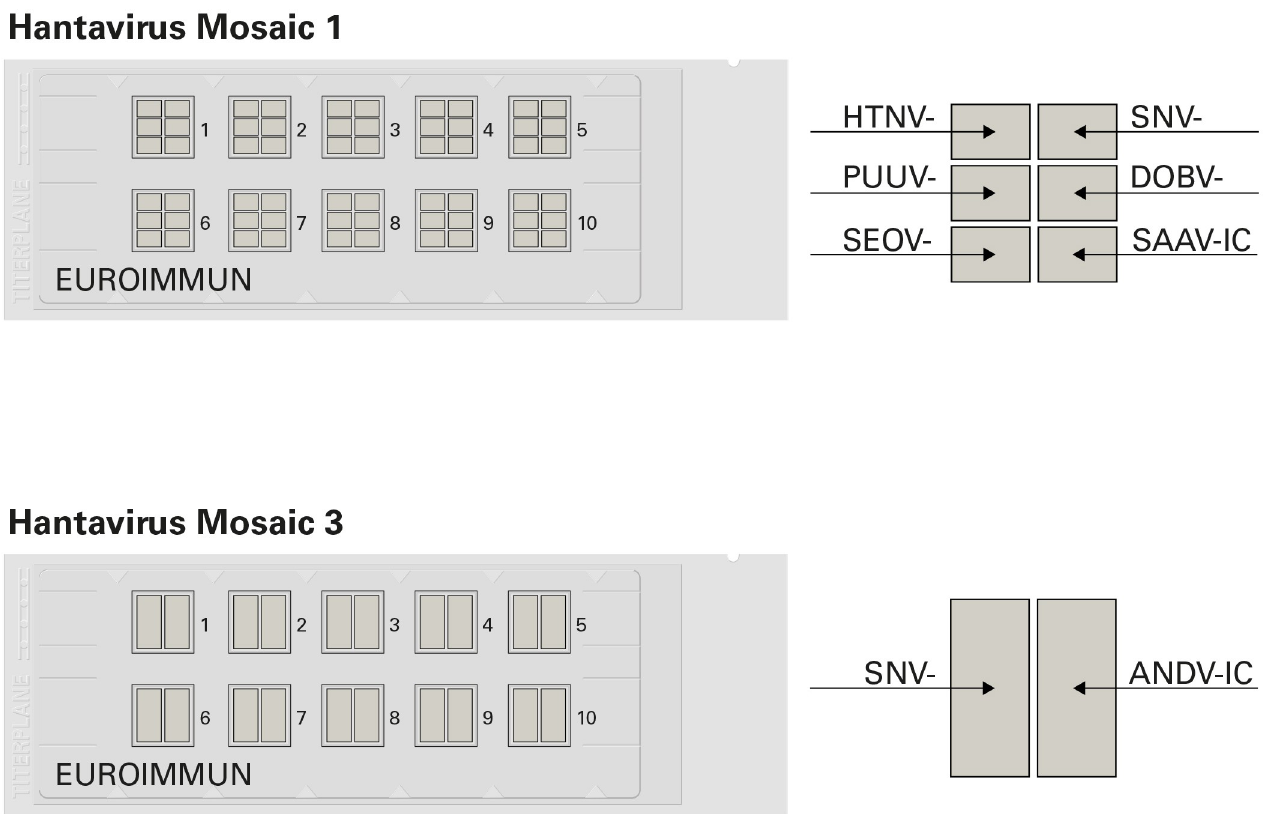
Fig 1. Immunofluorescence microscope slides for the multiparametric detection of hantavirus-specific antibodies. A microscope slide has ten reaction fields, each of which contains a biochip mosaic, allowing ten samples or sample dilutions to be incubated simultaneously with the same range of substrates. Due to identical incubation protocols, IgG and IgM testing can be performed on different reactions fields of the same slide using the respective secondary antibody conjugate. Hantavirus Mosaic 1 comprises mosaics of six biochips coated with Hantaan virus (HTNV)-, Puumala virus (PUUV)-, Seoul virus (SEOV)-, Sin Nombre virus (SNV)-, Dobrava virus (DOBV)- and Saaremaa virus (SAAV)-infected cells (-IC). Hantavirus Mosaic 3 consists of mosaics of two biochips coated with Sin Nombre virus (SNV)- and Andes virus (ANDV)-IC.